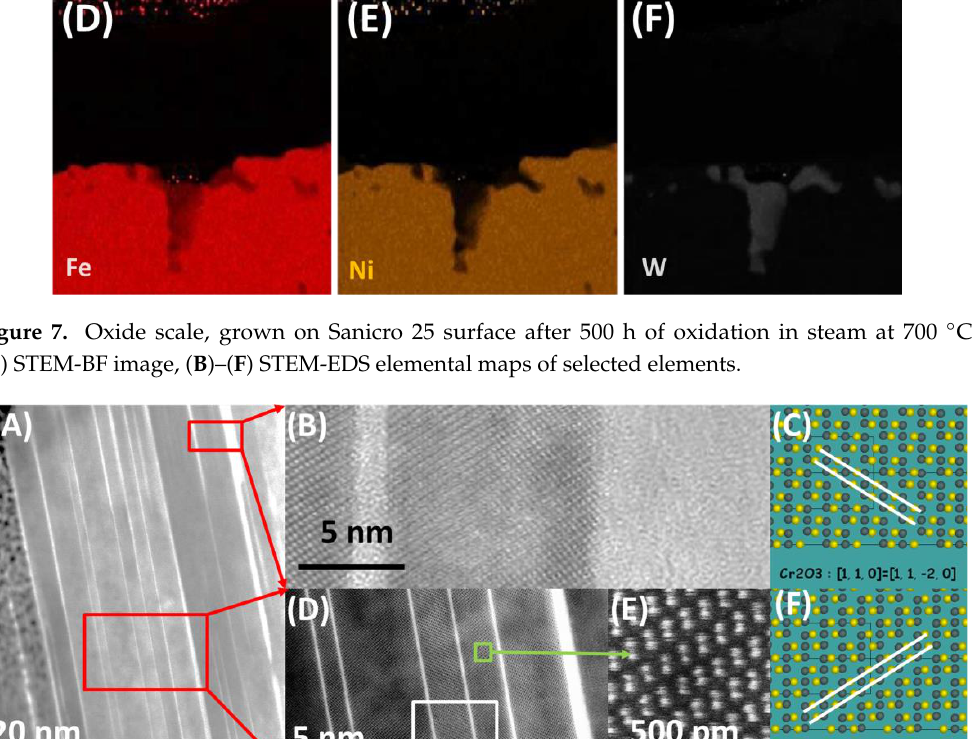
Figure 8. One plate of Cr 2 O 3 oxide scale at a high magnification: ( A ) Overview showing sandwich-like structure (STEM-BF); ( B ) HRTEM image showing amorphous structure between Cr 2 O 3 crystals; ( C ), ( F ) Cr 2 O 3 unit cell drawing, generated with JEMS software for two di ff erent zone axes; ( D ) few crystals at higher magnification (STEM-BF); ( E ) HRSTEM-HAADF image of Cr 2 O 3